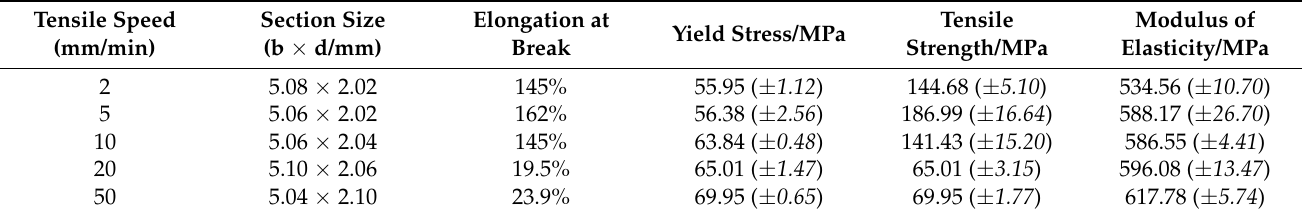
Table 6. PLA quasi-static compression experimental Table 5. PLA quasi ‐ static tensile test data.